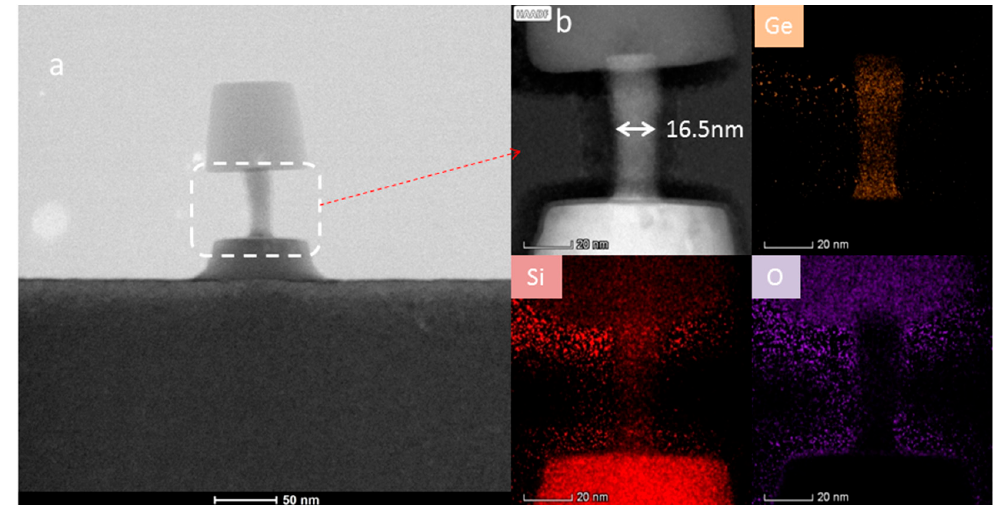
Figure 36. TEM and EDX mapping: ( a ) TEM picture of all structures; ( b ) HRTEM and EDS mapping of near isotropic etching region [113].